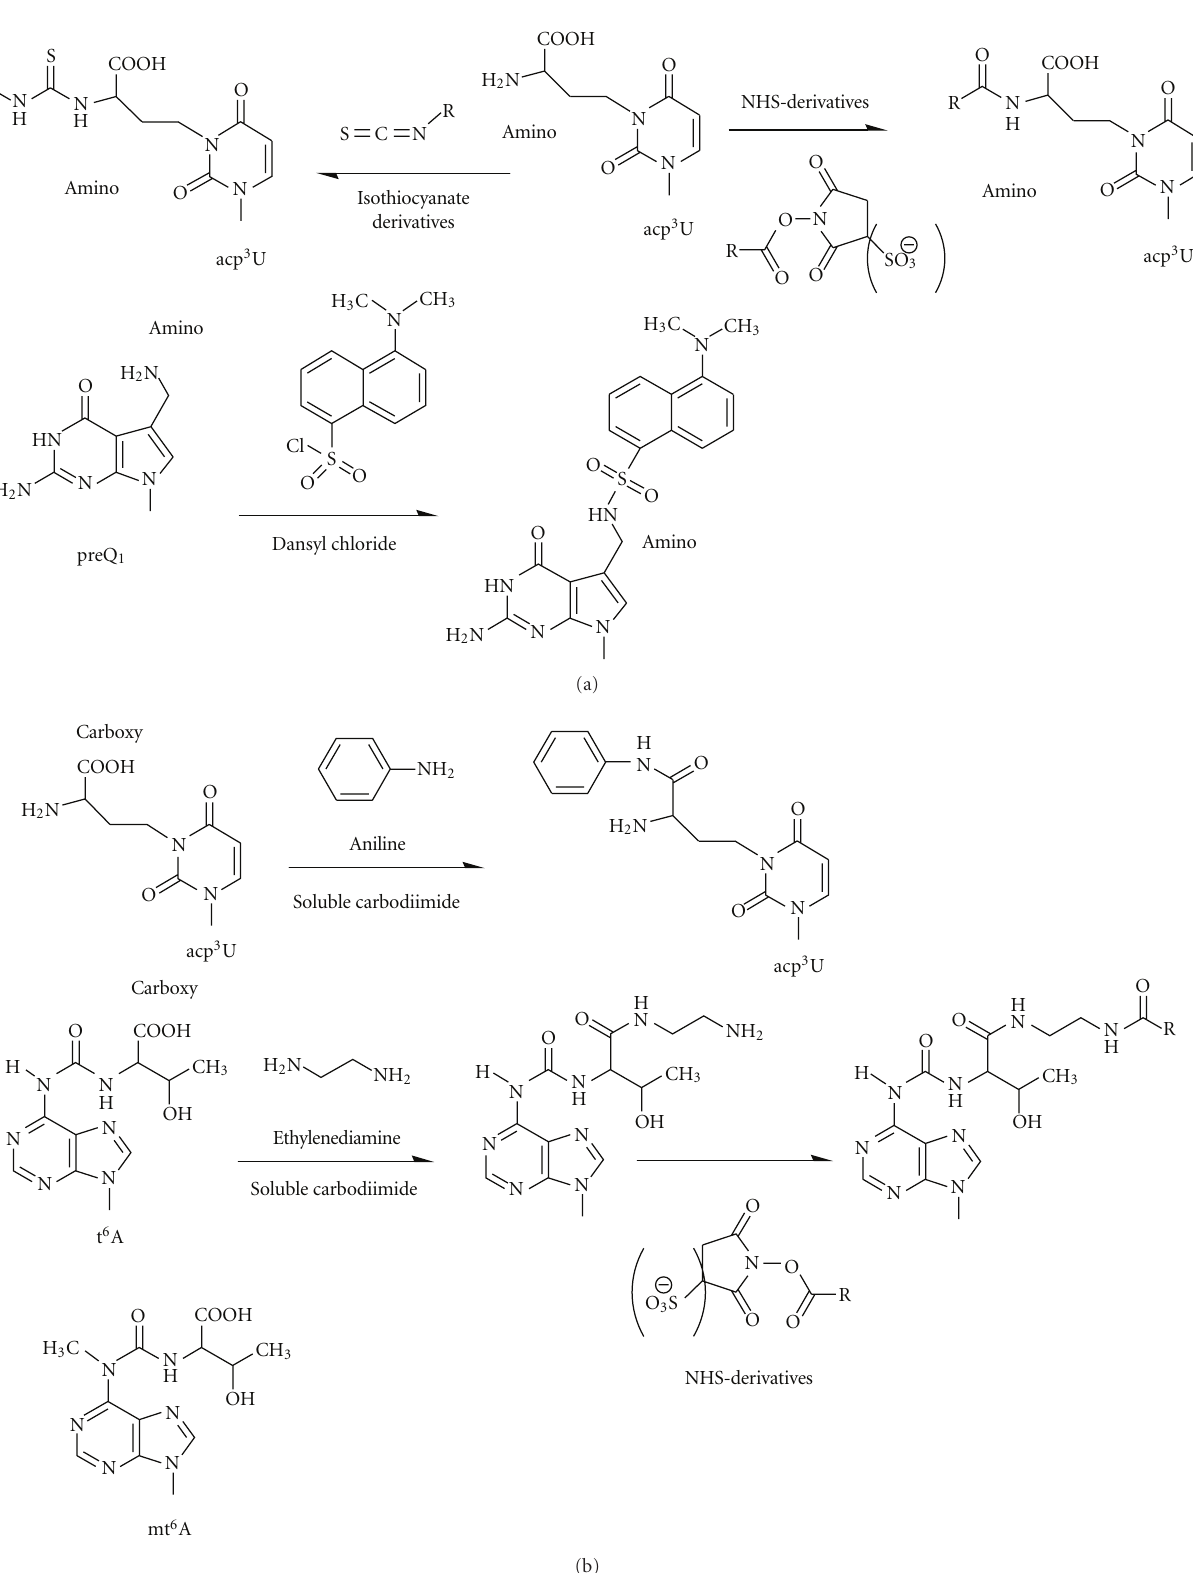
Figure 7: Specific reactivity of free NH 2 – (a) and –COOH (b) groups in modified nucleotides. acp 3 U is taken to illustrate the reactivity with isothiocyanate derivatives and NHS derivatives. Reaction with dansyl chloride is shown for preQ 1 (a). Reactions of free –COOH groups with aniline, ethylenediamine and similar molecules in the presence of soluble carbodiimide. The resulting free NH 2 -group of ethylenediamine may be further used for attachment of activated acyl (b). The structure of mt 6 A(m 6 t 6 A) is shown at the